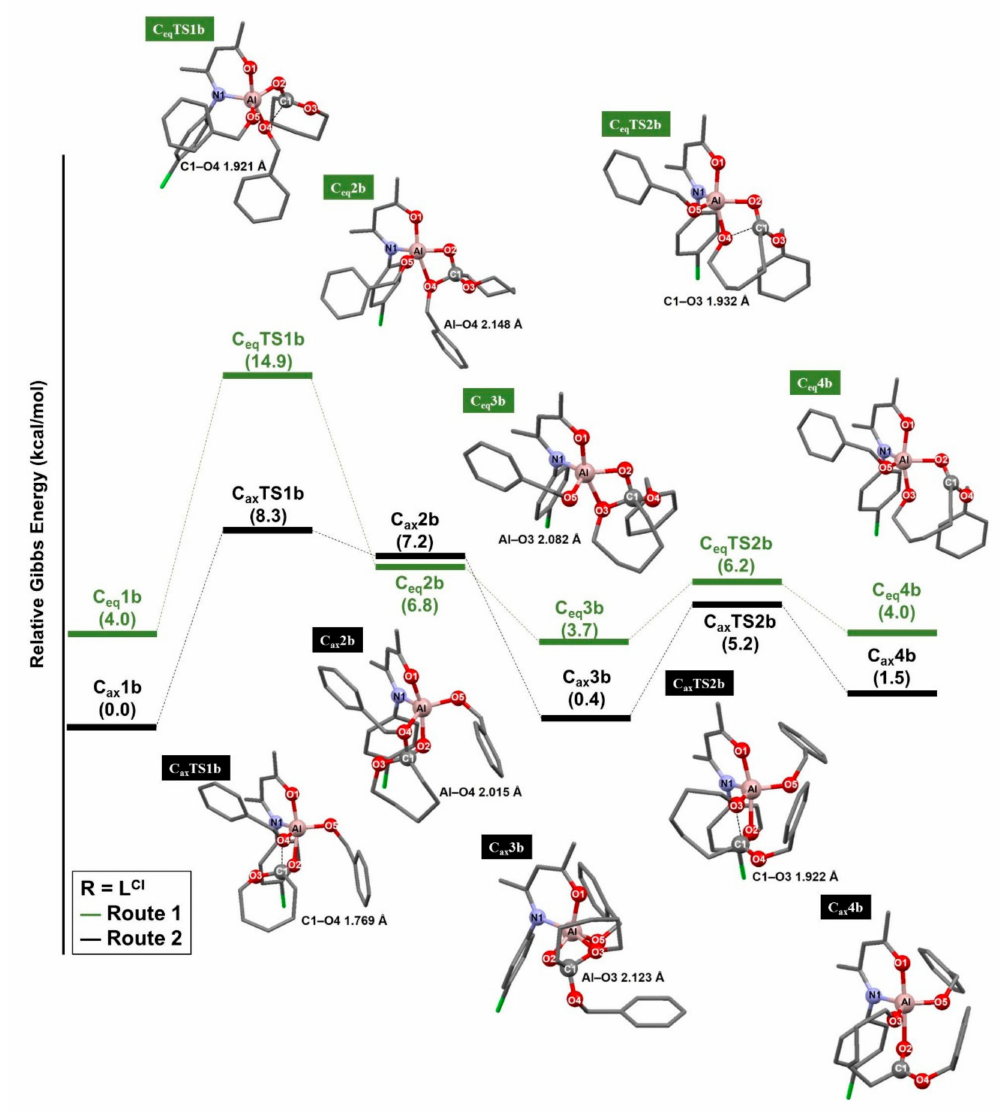
Figure 6. Reaction profile and optimized structures of the L Cl system. (Monomer: ε